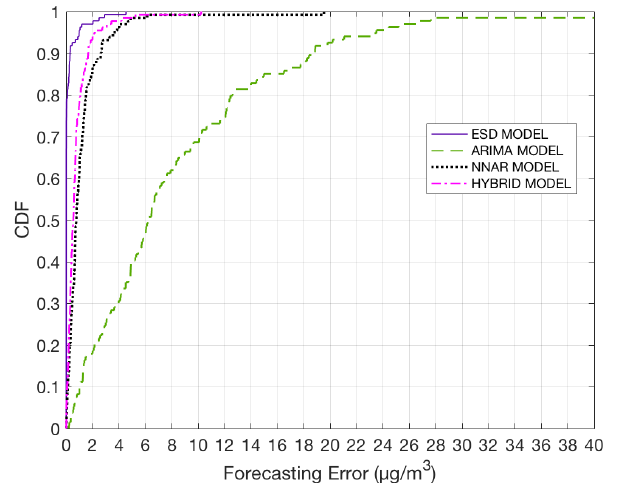
Figure 12. CDF plot for all four models for one hour prediction.